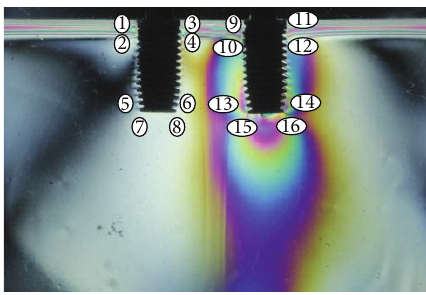
Figure 3: Representation of the points to be analyzed by Fringes